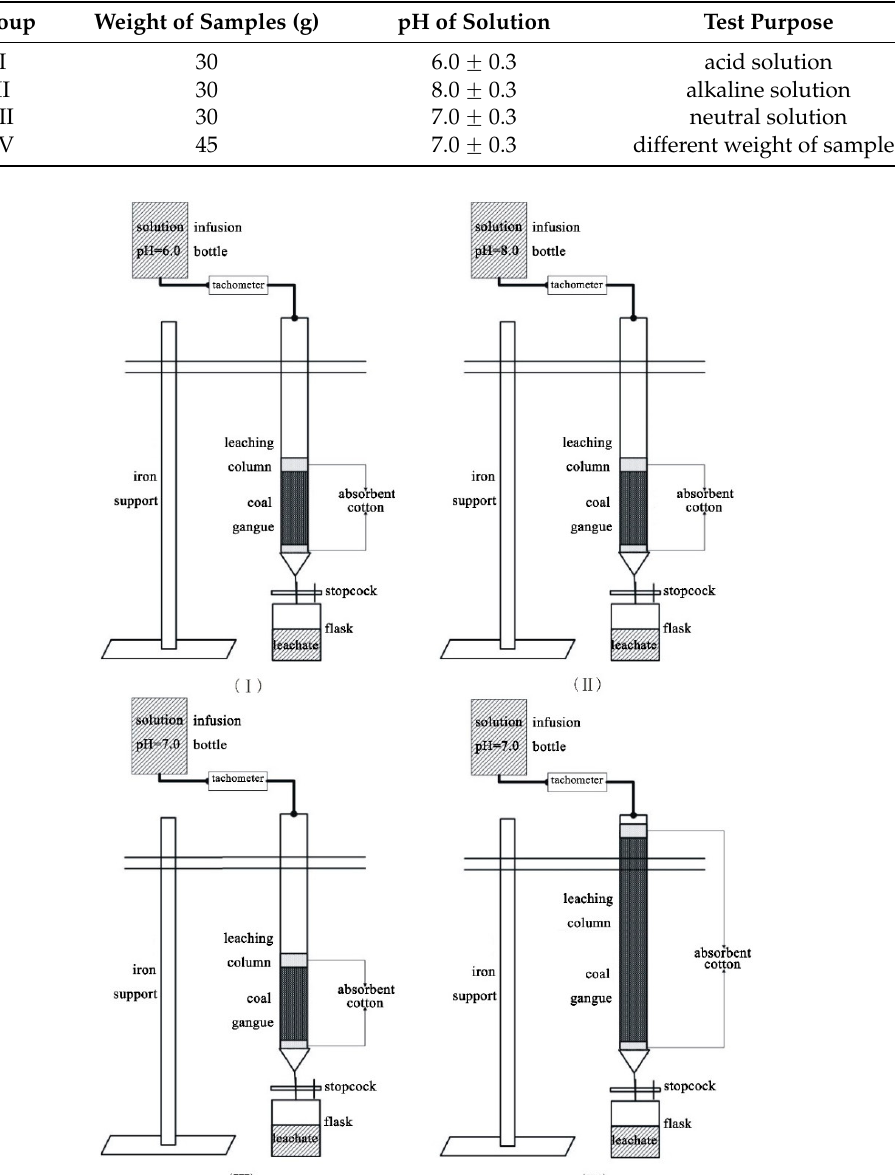
Figure 3. Installations of the leaching experiments: I, II, III and IV. Experiment I, 30-g samples, pH= 6.0 ± 0.3; Experiment II, 30-g samples, pH= 8.0 ± 0.3; Experiment III, 30-g samples, pH= 7.0 ± 0.3; Experiment III, 45-g samples, pH= 7.0 ± 0.3.